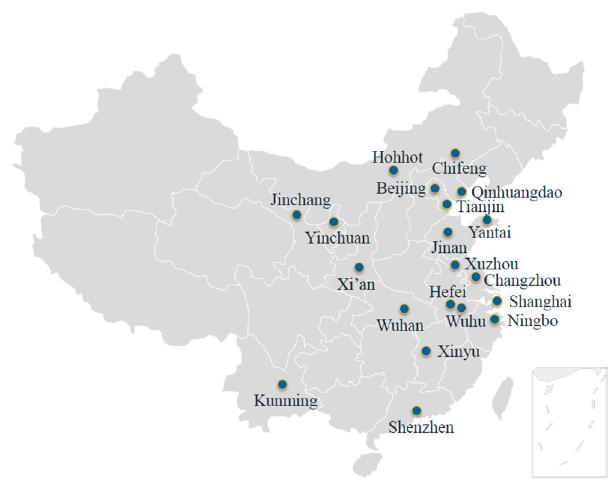
Figure 1. Geographical distribution of surveyed projects.